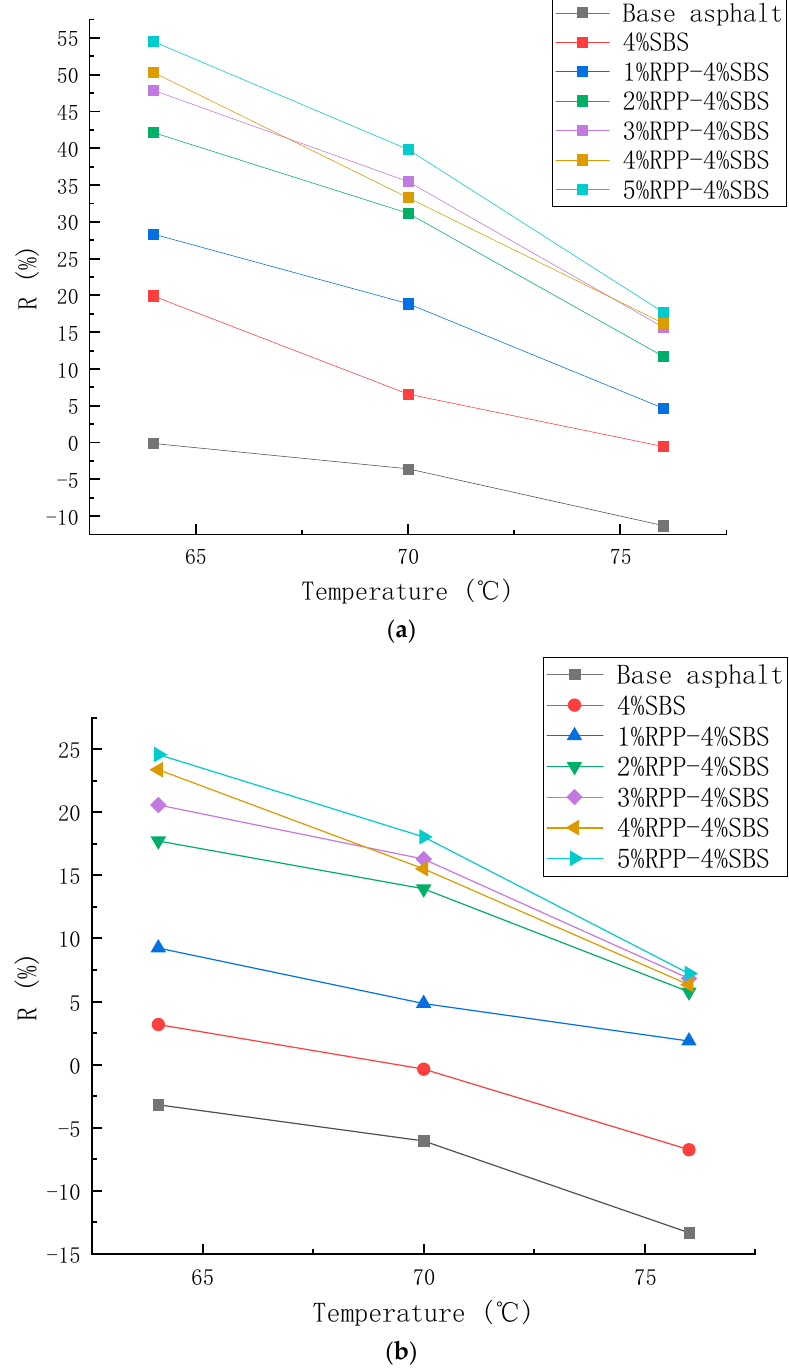
Figure 12. Changes in the average strain recovery rate of asphalt with temperature under different stress levels. ( a ) 0.1 kPa, ( b ) 3.2 kPa.